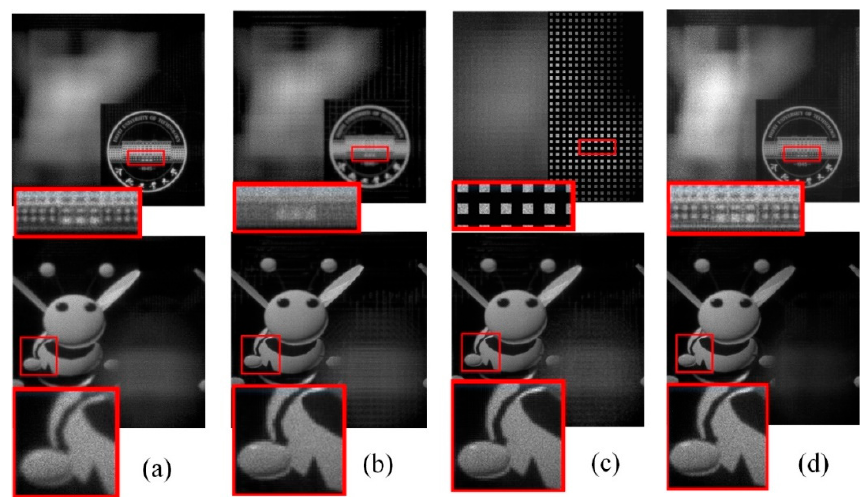
Figure 11. ( a ) Numerical simulation results with focal length f = 3 mm. ( b ) Numerical simulation results with focal length f = 6 mm. ( c ) Numerical simulation results with focal length f = 6 mm and partial aperture filtering. ( d ) Numerical simulation results with partial aperture filtering and MALT.